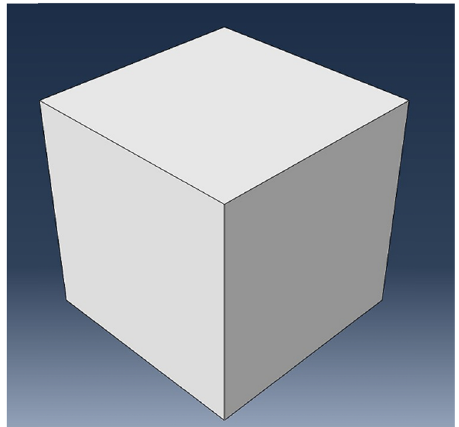
Figure 1: Recycled aggregate concrete